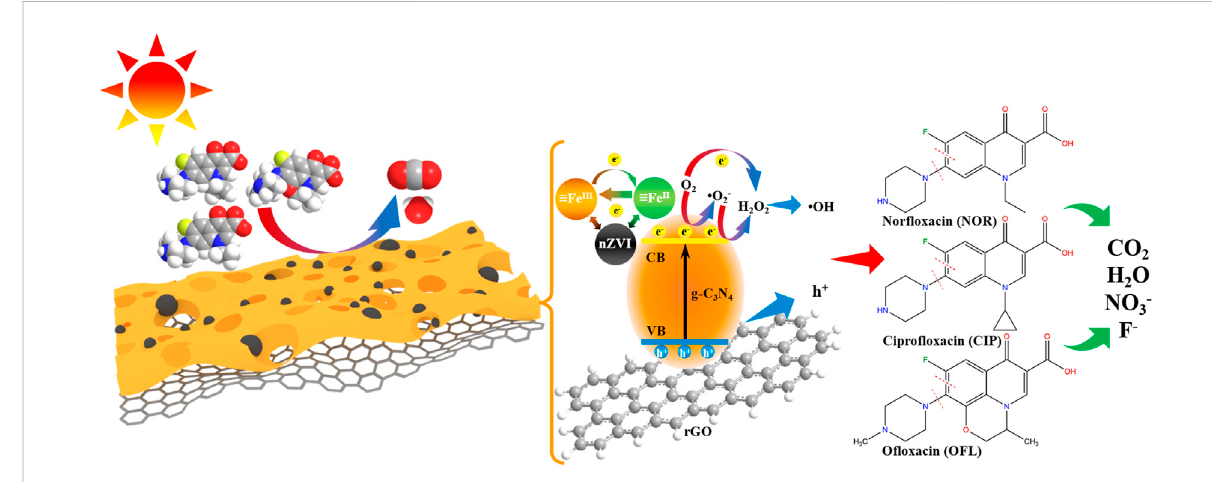
FIGURE 9 The possible photocatalytic degradation mechanisms of 10% IGCN.